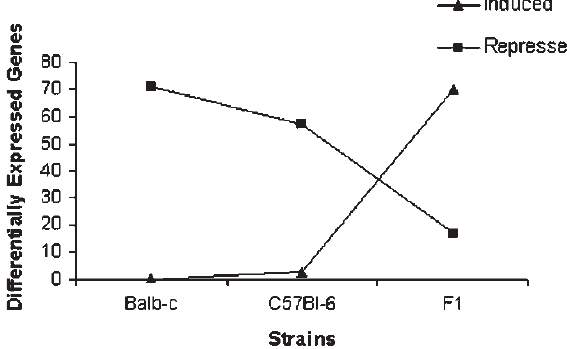
Figure 1. Number of significant induced or repressed genes in the fetal thymus during the emergence of TRBV8.1 recombination among inbred mouse strains. F1 ¼ (Balb-c £ C57Bl/6)F 1 .